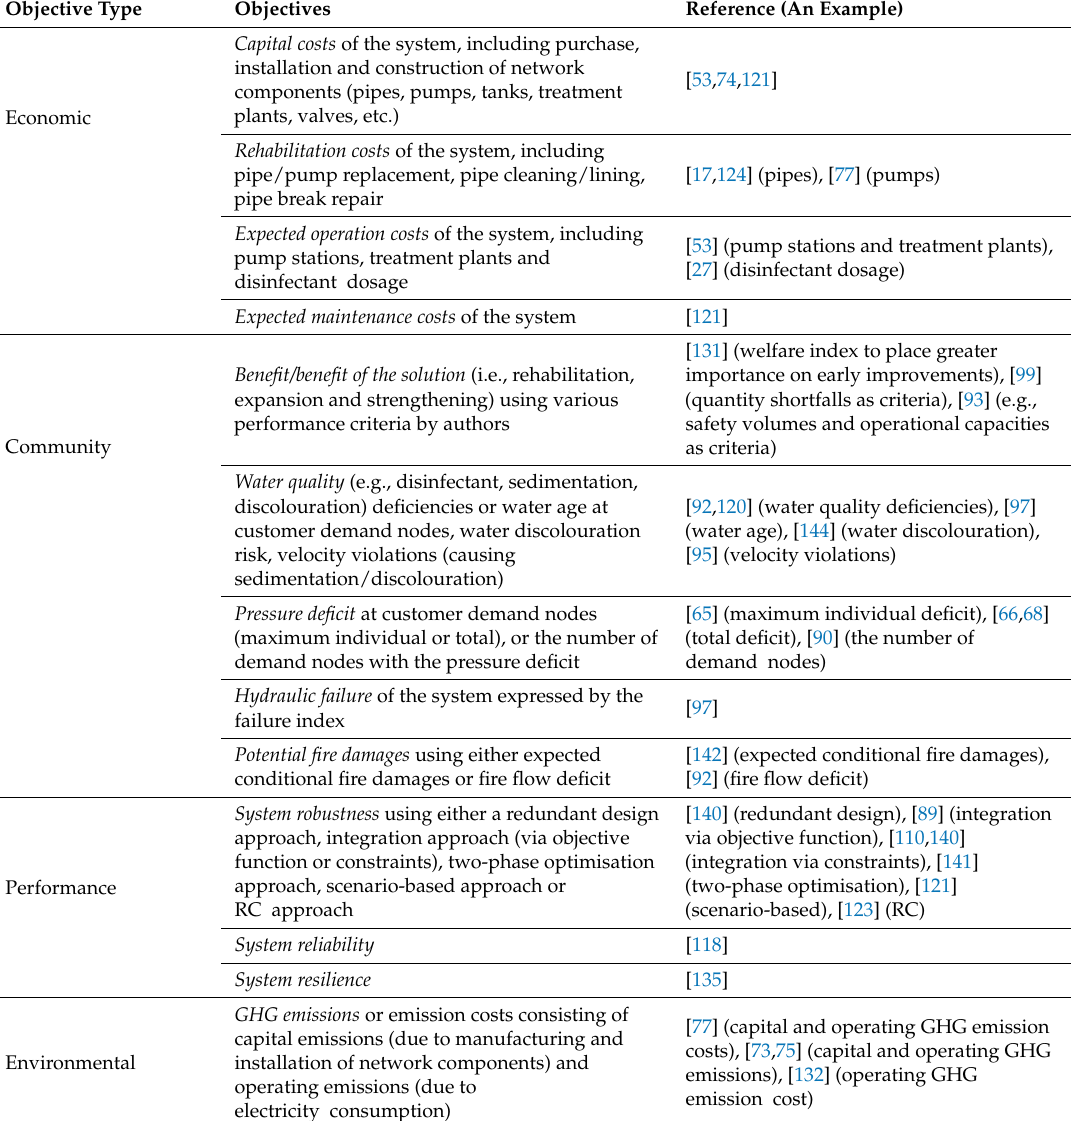
Table 1. Objectives of a general optimisation